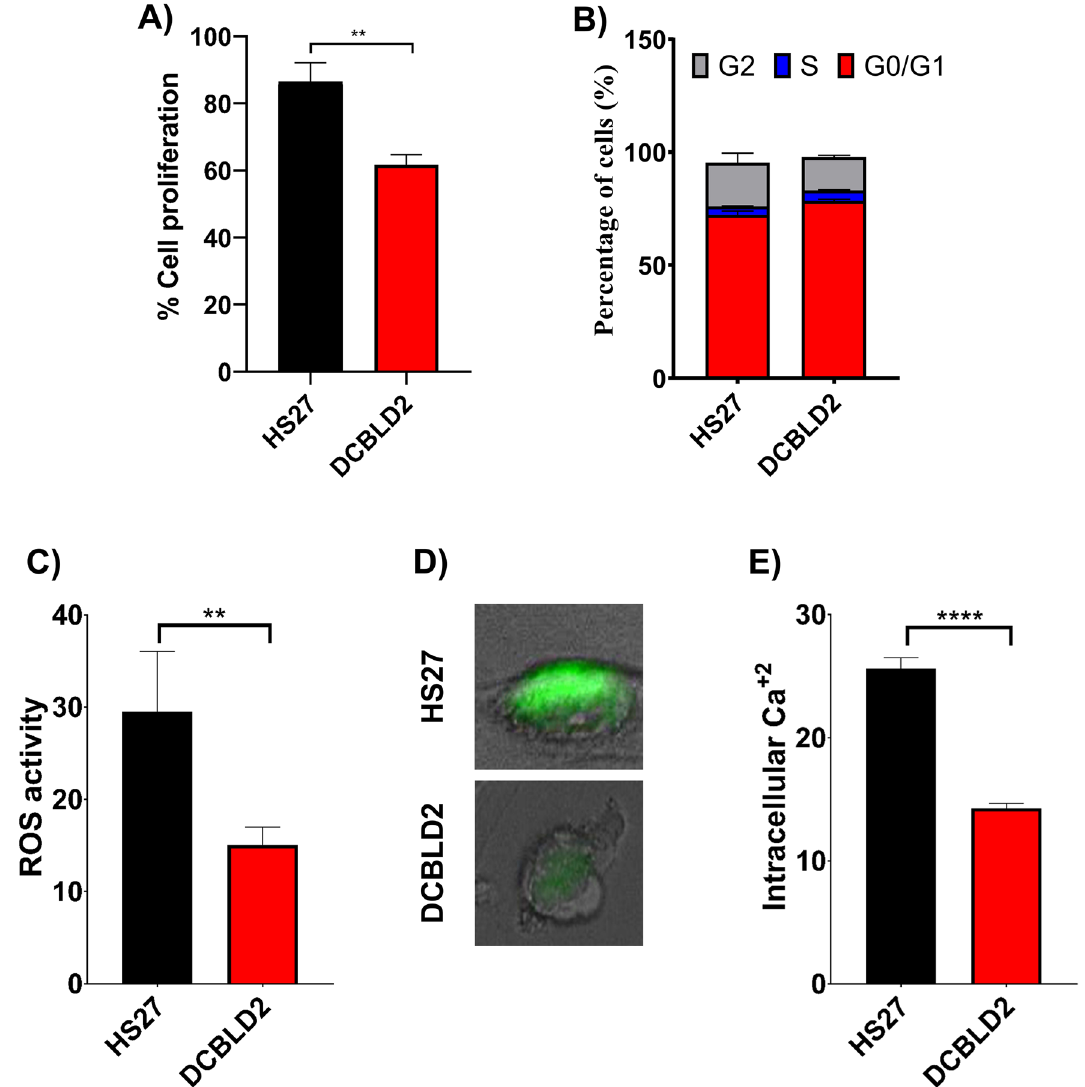
Figure 3. Functional characterization of the W27* variant in the DCBLD2 gene. ( A ) The rate of cell proliferation in patient and control fibroblasts determined by the MTT assay. A significant reduction in cell proliferation was observed for the index’s fibroblasts with W27* ( P = 0.0054). Error bars refer to the standard error of the mean of five technical repeats and four independent biological experiments (n = 4). ( B ) Quantification of the cell cycle distribution of W27* and normal control cells. Index fibroblasts with the DCBLD2 W27* variant had slight prolongation of G1 phase. Error bars refer to the standard error of the mean of two biological repeats. Student’s t-test using GraphPad Prism software. ( C ) Quantitation of reactive oxygen species (ROS) in the proband’s fibroblasts with the nonsense mutation and normal control fibroblasts performed using the cell-permeable fluorogenic probe 2 ′ ,7 ′ -dichlorodihydrofluorescein diacetate ( p = 0.0015). Data are shown as the mean value ± SD, and five independent biological repeats were performed (n = 5). ( D ) Visualization and localization of the intracellular calcium level in a single cell from the patient’s and control fibroblasts. ( E ) Quantification of the intracellular Ca2 + level in the index’s fibroblasts with W27* compared to the normal control ( p < 0.0001). Error bars refer to the standard error of the mean of five technical repeats and four independent biological experiments (n =